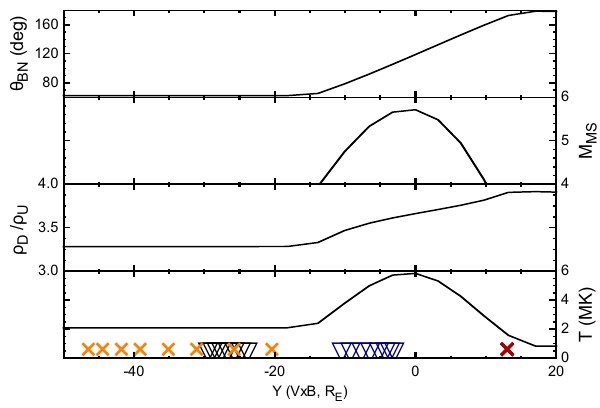
Fig. 8. Shock parameters and Rankine-Hugoniot predictions against bowshock y V × B coordinate: (a) θ Bn , (b) the magnetosonic Mach number M ms , (c) the ratio of downstream to upstream bulk density ρ D /ρ U , and (d) the downstream temperature. The triangles and crosses in (c) are correspond to those in Fig. 4b.